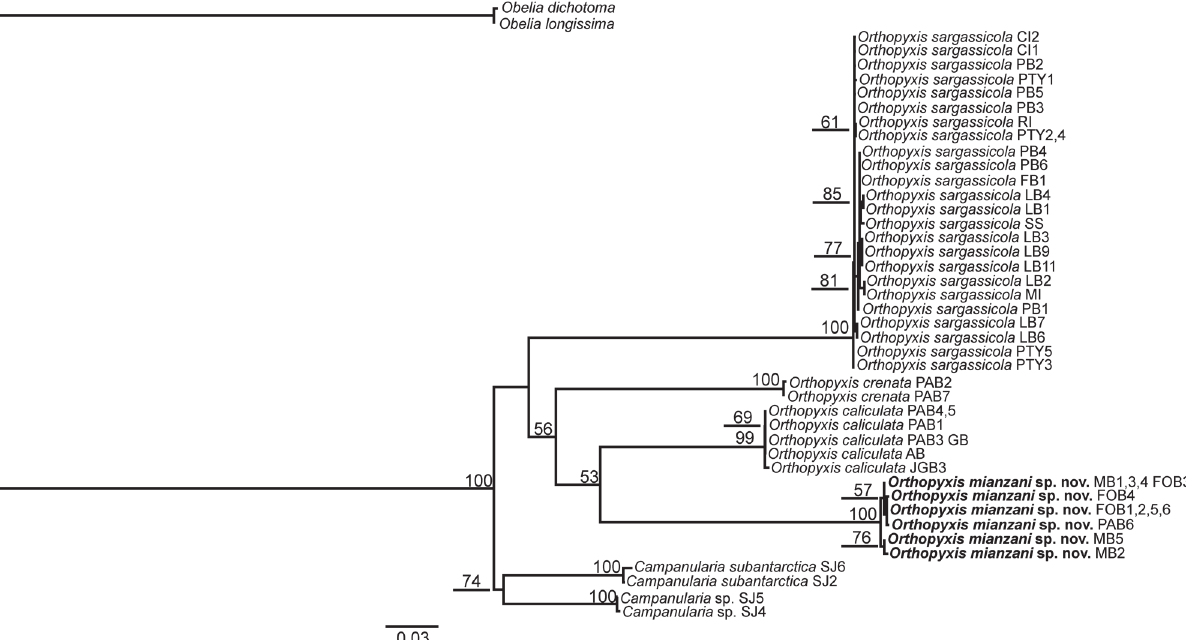
Fig 2. Maximum Likelihood tree based on 16S, COI, ITS1 and ITS2 data. Bootstrap values are shown for each node. Nodes without numbers indicate support below